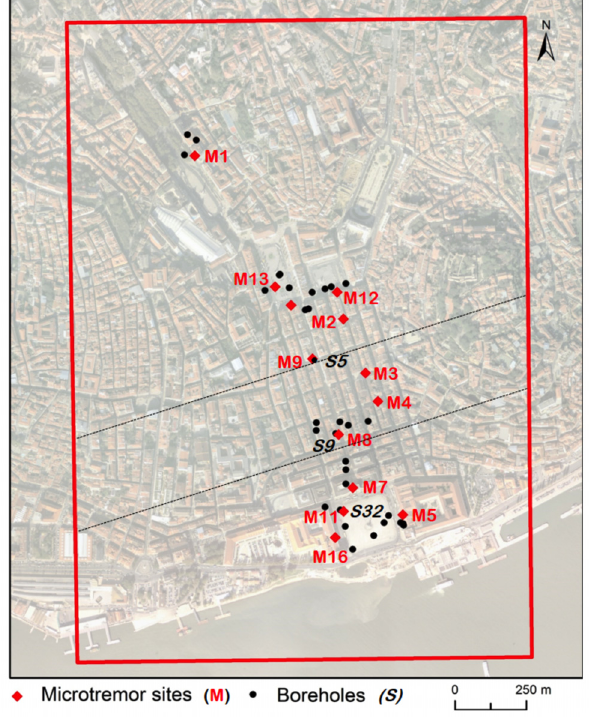
Figure 8. Location of the ambient vibration measurements (M) and the closest geotechnical boreholes (S). Boreholes used to calibrate values are identified. The dashed black lines separate the the V S three defined zones (northern, central and